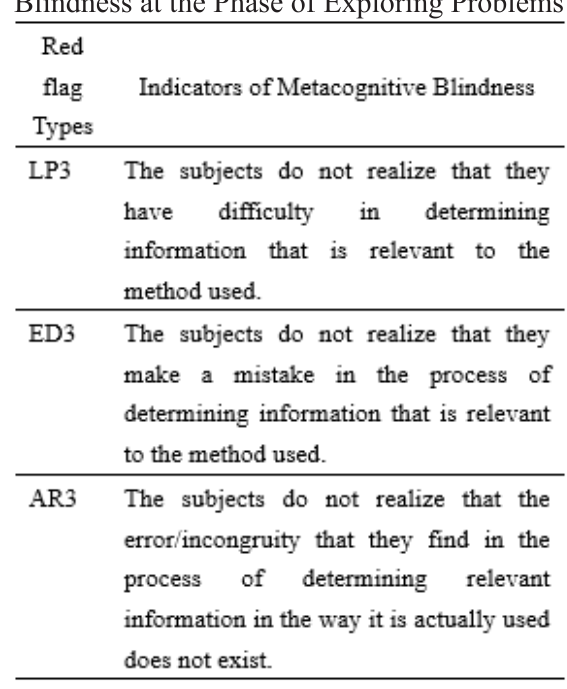
Table 3. Indicators of Metacognitive